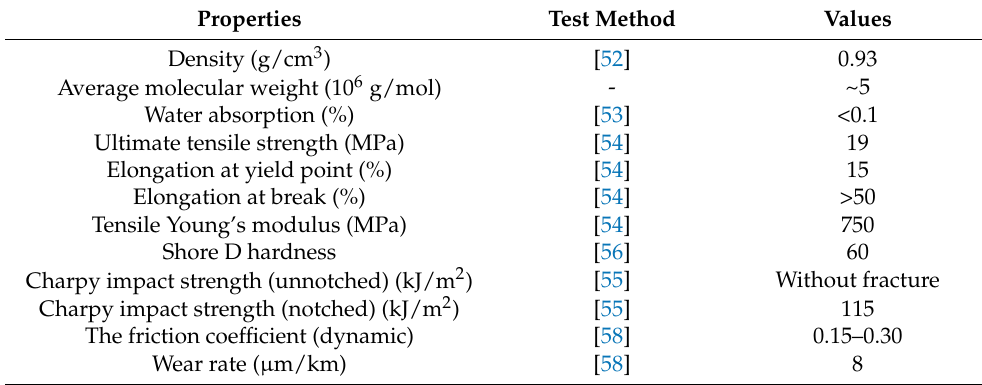
Table 14. The properties of the ‘TIVAR ® 1000’ material fabricated by ‘Mitsubishi Chemical Advanced Materials’ [57].